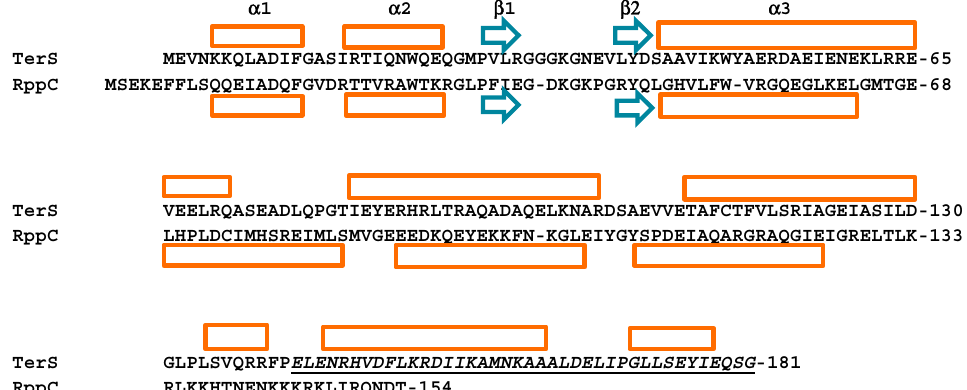
Figure 3. Secondary structures of TerS- λ and RppC. The top alignment shows the DBDs of the two proteins. The TerS- λ DBD structure is from DeBeer et al. [22] and Fillol-Salom et al. [1] and the RppC structure if from Fillol-Salem [1]. The TerS- λ structure or residues 66 to 181 is the JPred prediction (www.compbio.dundee.ac.uk/jpred/, accessed on 1 December 2021). α -helixes are indicated by orange rectangles and β -strands by blue arrows. TerS- λ residues proposed to form the TerL-binding domain are underlined and italicized. RppA, B, C, and G have 135, 146, 153, and 139 residues, re-